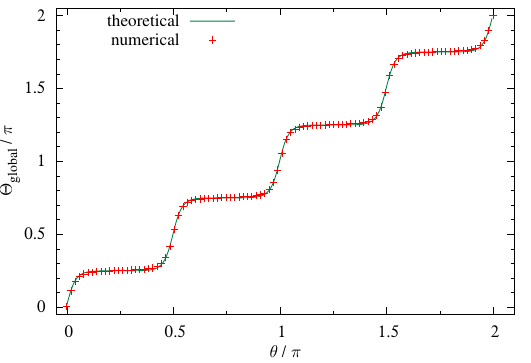
Figure 20 : Numerical solution possessing four angular domain walls. The theoretical line in green is from eq. (2.51) and the red crosses are numerical phase data extracted from (cid:12)gure 19. The data are extracted at r = 9 and here (cid:20) = eq.